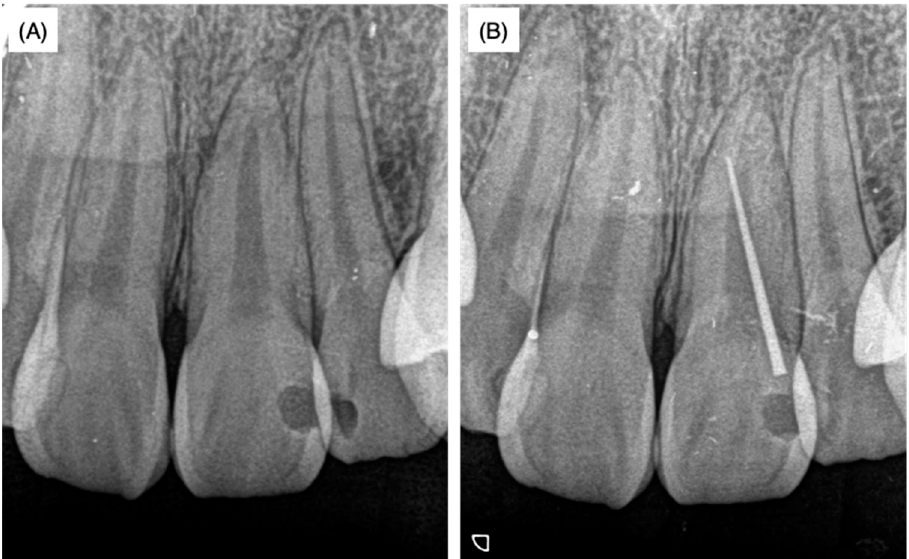
Figure 1. X-ray films without ( A ) and with ( B ) the insertion of gutta-percha points when the patient was 18 years and 8 months old. These X-rays were taken at a private dental clinic before the patient came to our university dental hospital.